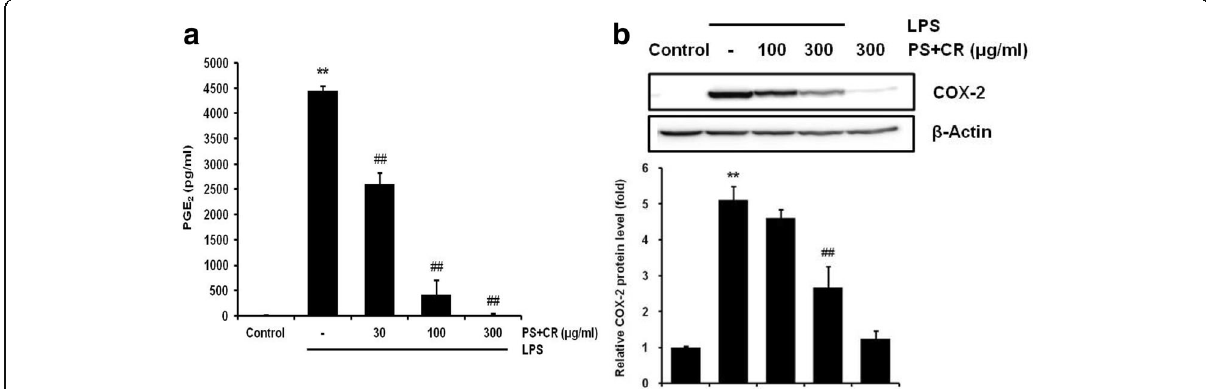
Fig. 3 Inhibition of the LPS-induced prostaglandin E 2 (PGE 2 ) secretion and cyclooxygenase-2 (COX-2) expression by PS + CR. RAW 264.7 cells were treated with 30 – 300 μ g/ml of PS + CR for 1 h prior to the addition of LPS (1 μ g/ml) and further incubated for 24 h. a Effects of PS + CR on the levels of PGE 2 . PGE 2 concentrations in the culture medium were assayed using the PGE 2 ELISA kit as detailed in the Methods section. b Effects of PS + CR on COX-2 protein expression. Equal amounts of total protein (50 μ g) were separated by SDS-PAGE. β -Actin was used as a loading control, and the bar chart shows the quantitative evaluation of COX-2 bands by densitometry. Values represent the mean ± S.D. of three independent experiments (significant compared to the control, ** p < 0.01; significant compared to LPS alone, ## p <